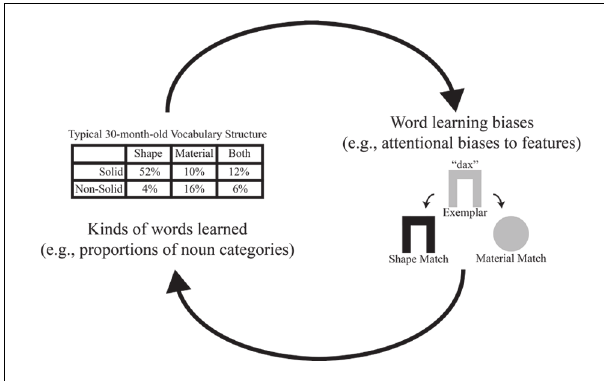
FIGURE 1 | Schematic of the hypothesized developmental feedback loop. On the left side are the kinds of words that children learn (represented here as proportions of different categories of nouns, as we used in our model). On the right side are attentional biases to features in word learning (represented here with a classic novel noun generalization